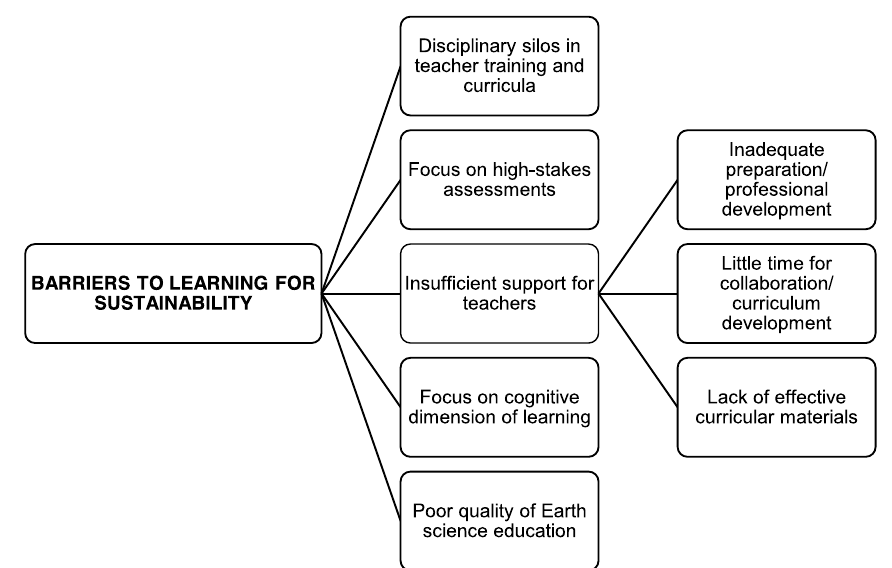
Fig. 2 Barriers to learning for